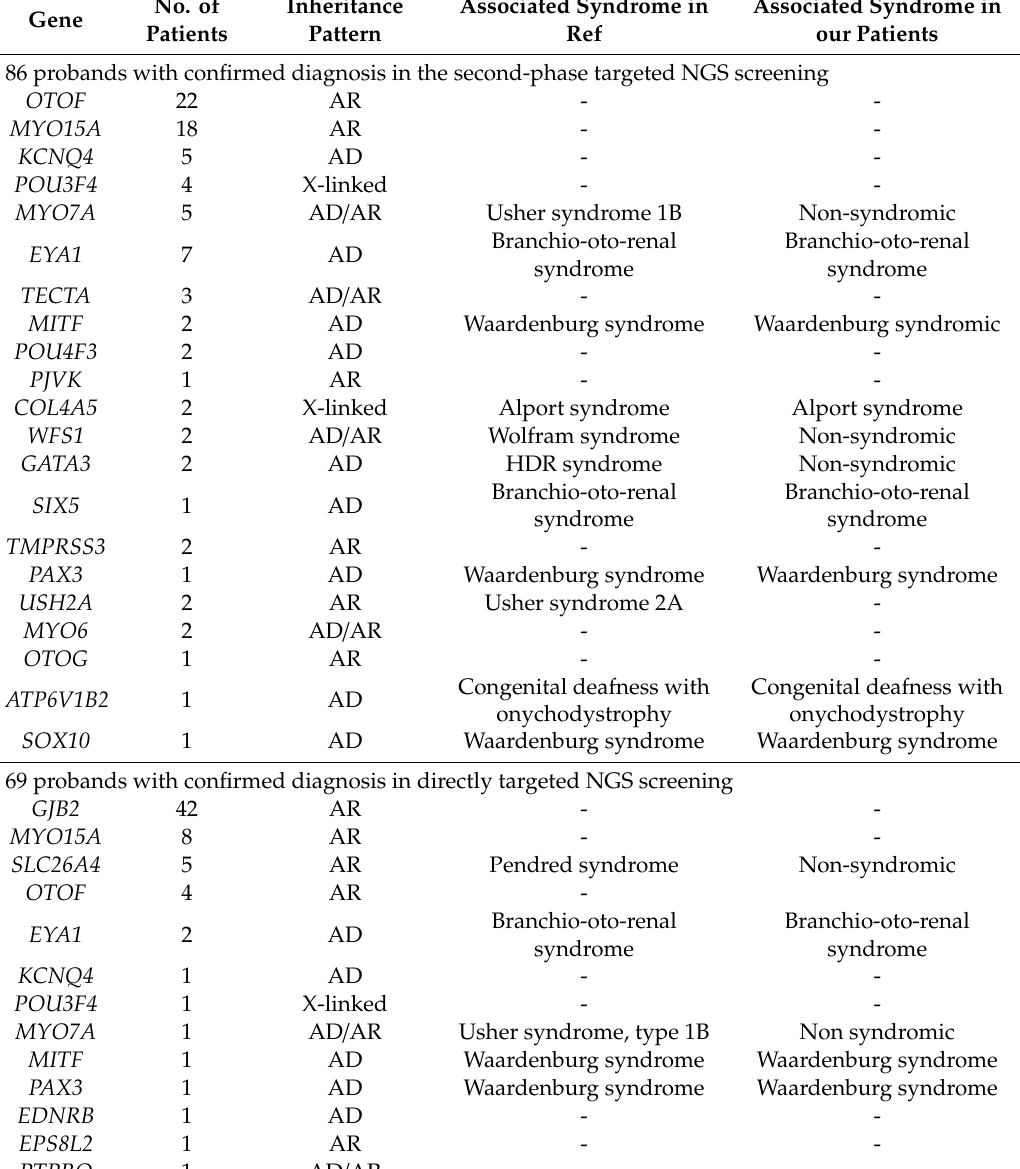
Table 1. Deafness genes detected with targeted NGS examination in Taiwanese patients. No. Gene